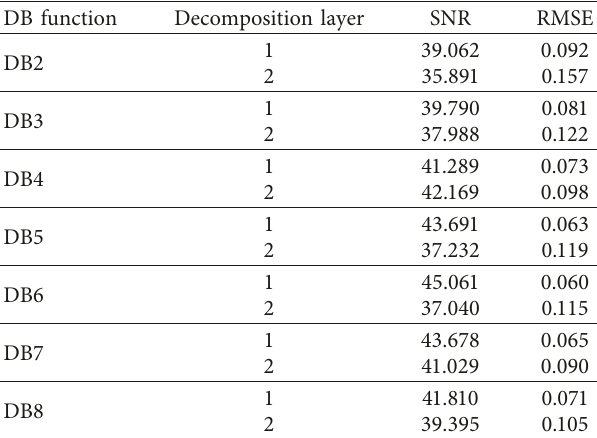
Table 4: RMSE and SNR of different DB functions under different decomposition